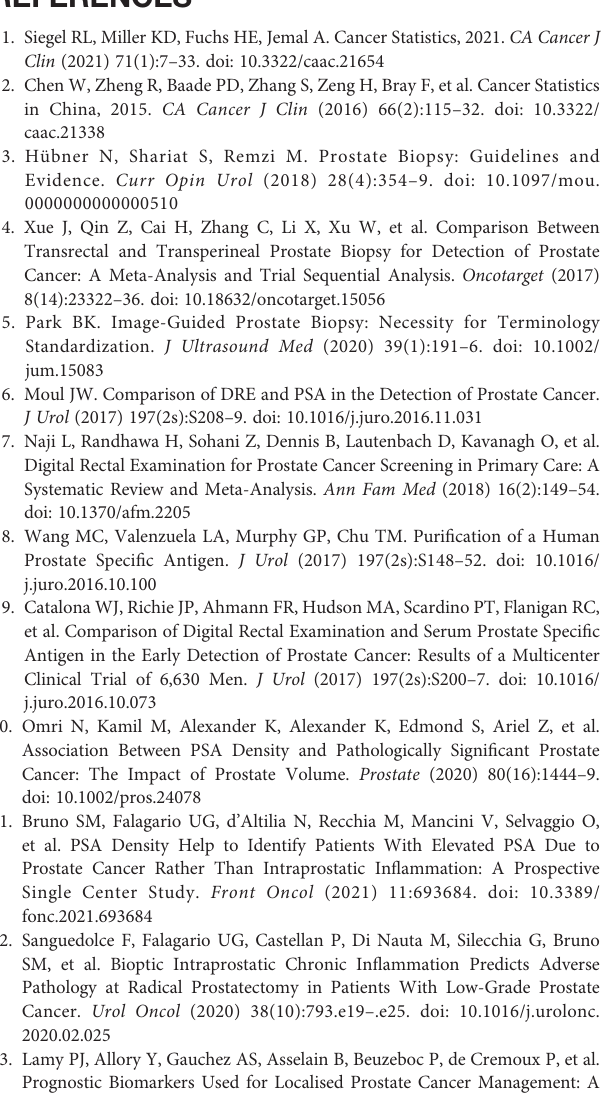
Supplementary Figure 3 | External validation of the nomogram (csPCa) in the DF cohort and the ZD cohort. (A, B) Discrimination of the nomogram was evaluated by AUC;itwas0.859 intheDF cohortand0.892in theZDcohort.Calibration curvesof the DF cohort (C) and the ZD cohort (D) illuminate the great agreement between the predicted risks ofcsPCa and the observed incidence ofcsPCa. The bluedotted line represents an ideal fl awless model. Supplementary Figure 4 | Decision curve analysis was exhibited to estimate the clinical usefulness of the nomogram (csPCa). The quanti fi ed net bene fi ts can be measured at different threshold probabilities. The y-axis denotes the standardized net bene fi t, and the x-axis denotes the threshold probabilities. The red line represents our nomogram, the gray line represents the condition that all patients have csPCa, and the black line represents the condition that none have csPCa. Supplementary Figure 5 | Internal validation of the nomogram in the KD cohort for three PSA groups. (A,B, andC)ROC curveofthe three groups for assessingthe